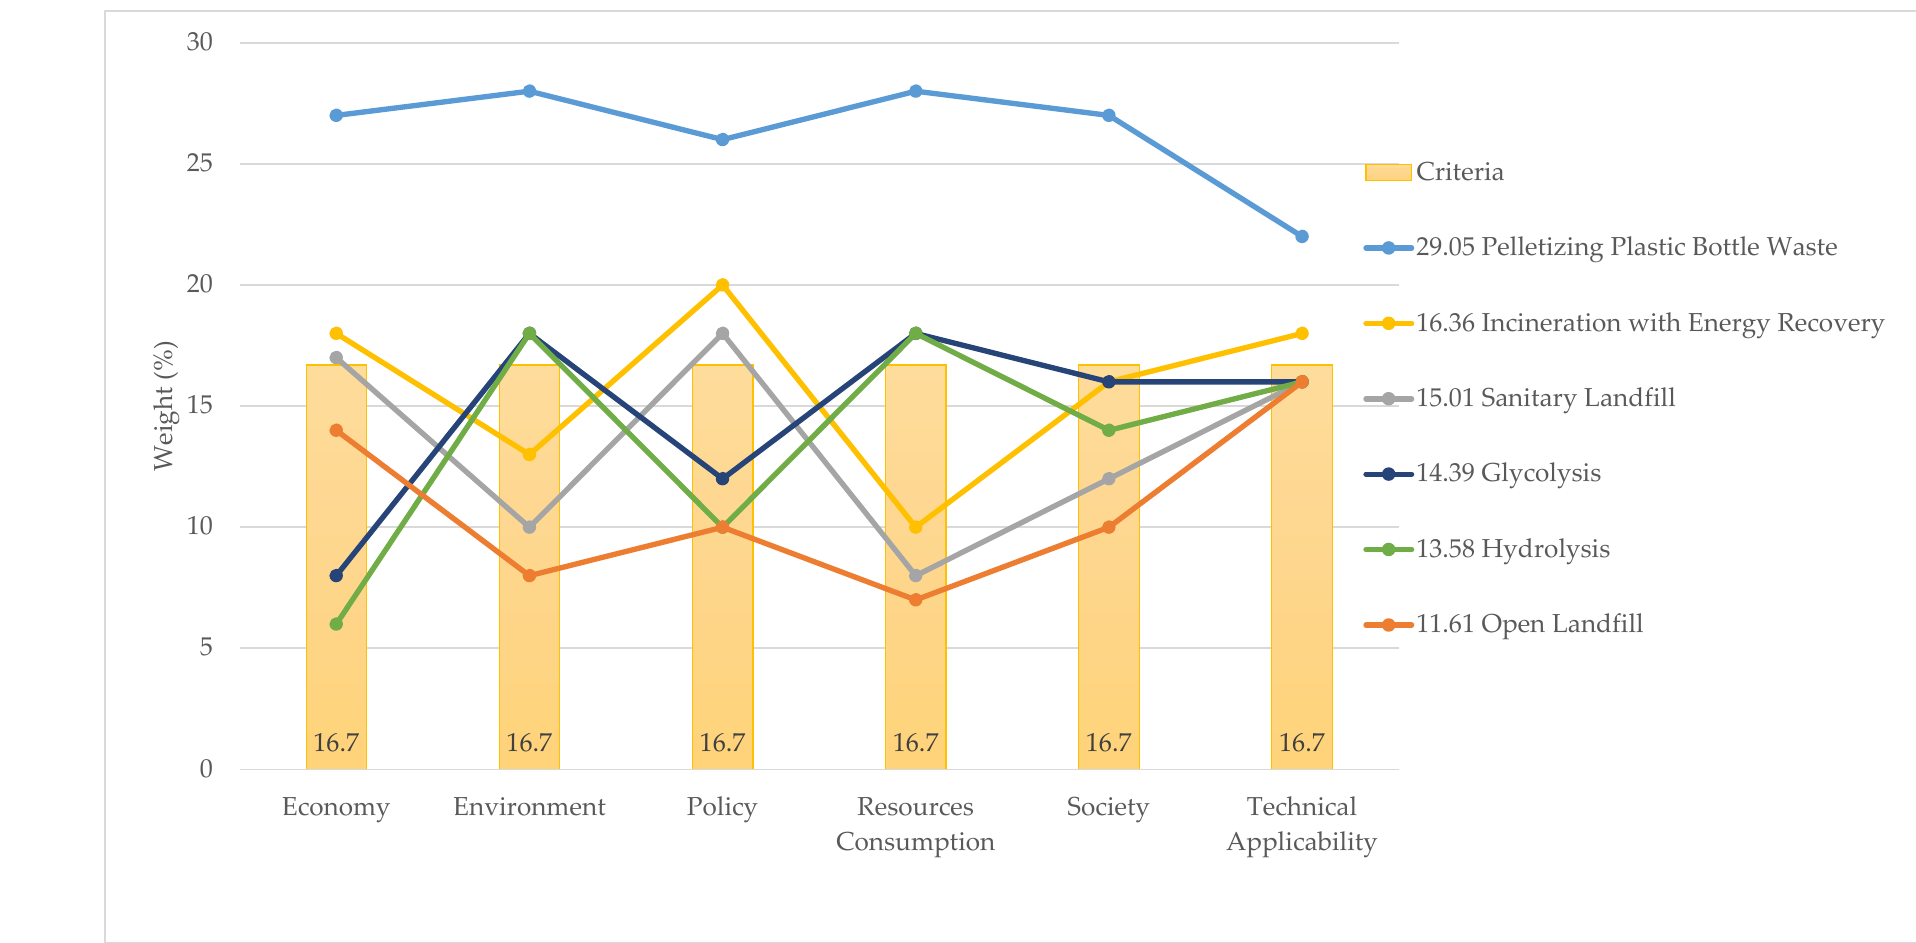
Figure 11. Sensitivity analysis: AHP model at an equal priority of criteria (%).